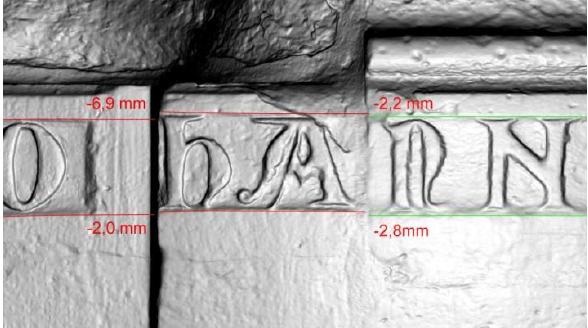
Figure 6. Deviation in the ribbon’s base lines between two stones